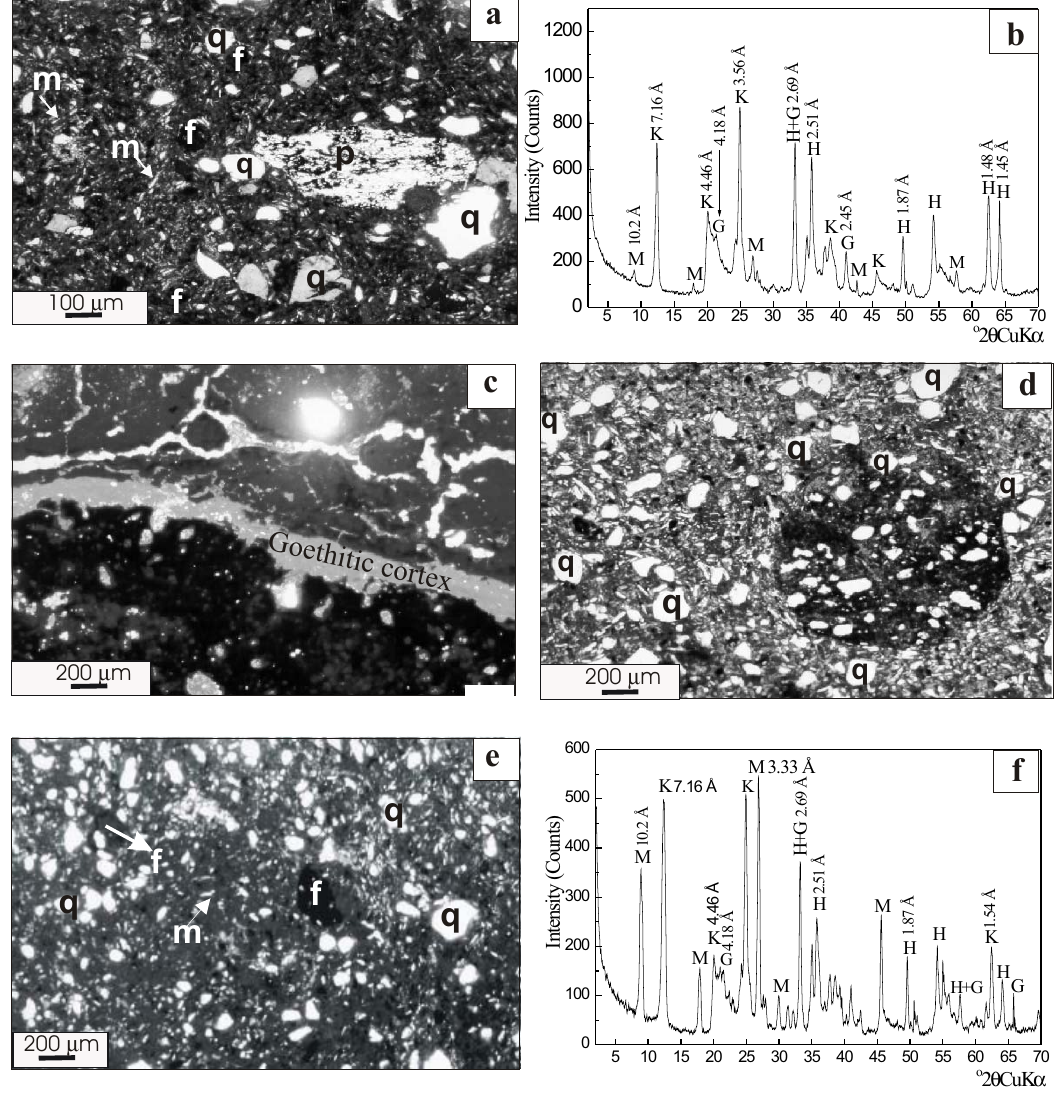
Fig. 4 – Nodular (N) and Massive clayey facies (Mc). a) Optical micrograph (plane-polarized light) of the nodular facies showing the porphyroskelic structure formed by quartz (q) and muscovite (m) skeleton together with lithorelictal nodules of phyllite (p) and ferruginouspedorelictalnodules(f). b)X-raydiffractionpattern(Cuk α radiation)showingthecompositionofthematrixofthenodular facies. c) Optical micrograph from the border of a ferruginous nodules of the nodular facies showing a cortex of goethite defining a sharp external boundary with the matrix. d) Optical micrograph of a nodule of the nodular facies with undifferentiated internal fabric showing the enclosing soil fabric with quartz (q) skeleton. e) Optical micrograph (plane-polarized light) of the massive clayey facies showing the skeleton with quartz (q), muscovite (m) and ferruginous pedorelictal nodules (f). f) X-ray diffraction pattern (Cu k α radiation) showing the composition of the matrix. K= Kaolinite, M = muscovite , H = hematite, G = goethite.